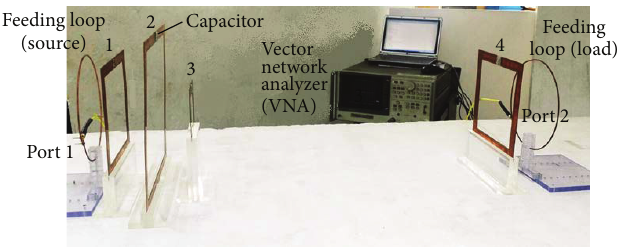
Figure 6: Photograph of experimental